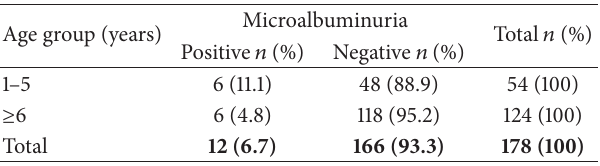
Table 5: Age groups of participants with and without microalbu- minuria.